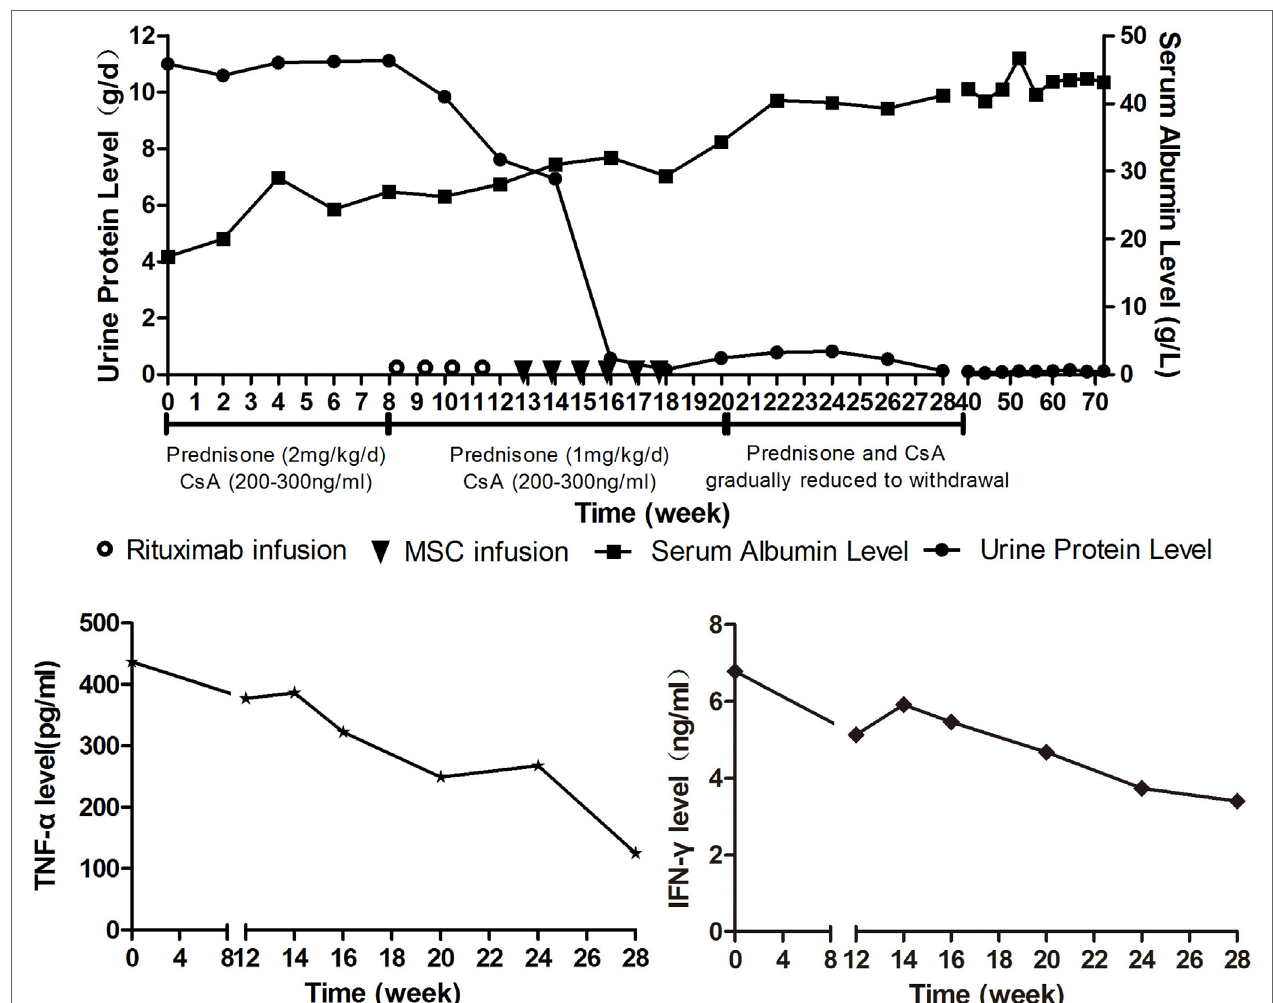
FIgURe 2 | (a) (Above) course of proteinuria and serum albumin during treatments. Prednisone (2 mg/kg/day) and cyclosporine A (serum values maintained at 200-300ng/ml) was administrated to the patient for 8 weeks after Nephrotic syndrome diagnosis, but the urine protein remained at a high level. Rituximab was given intravenously at a dose of 100 mg weekly on day 1 of weeks 9, 10, 11, and 12. Mesenchymal stem cells (MSCs) from the bone marrow of a third-party donor were administered from weeks 13 to 18. The dose was 1 × 10 6 cells/kg/infusion with a total of six doses planned in weekly intervals. (B) (Below) TNF- α and IFN- γ serum levels during